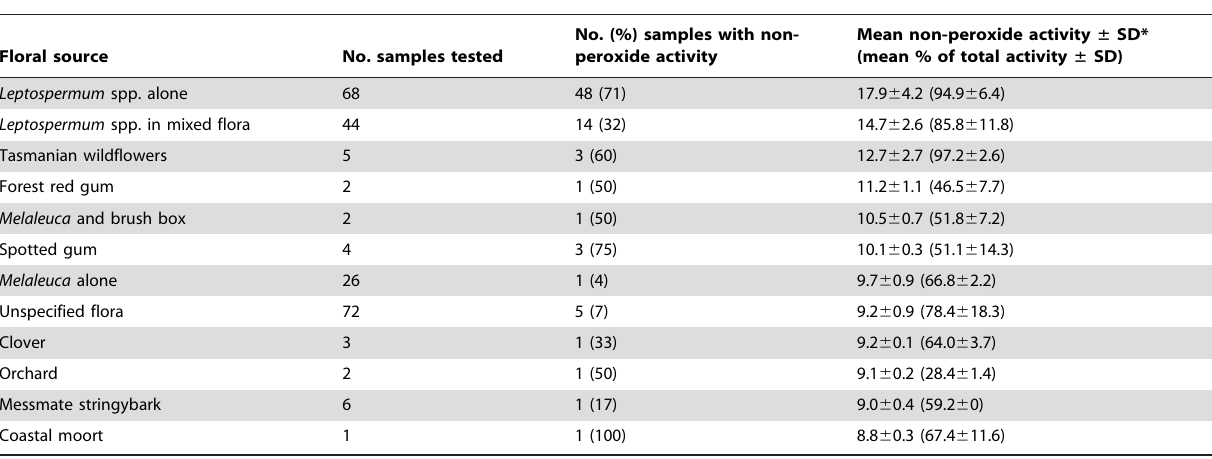
Table 2. Honey samples exhibiting non-peroxide antibacterial activity.